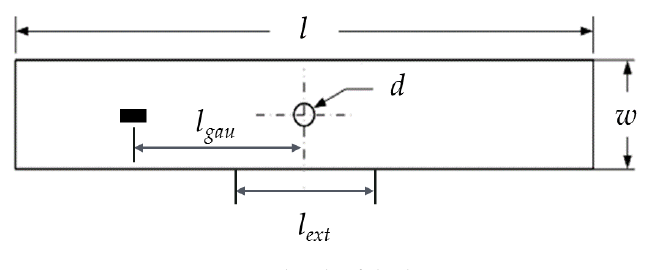
Figure 9. A sketch of the laminate. Table 2. Geometric dimensions of the laminates.